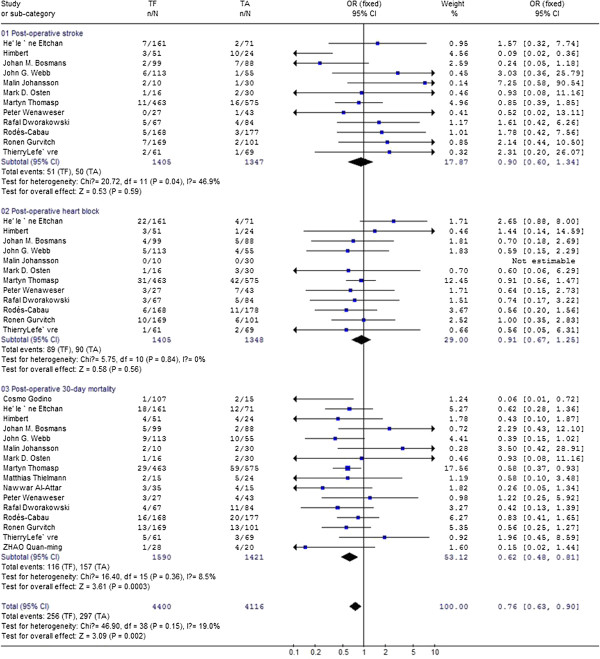
Compare 30-day post-opertive mortality, stroke, heart block between transfemoral aortic valve implantation versus transapical surgery aortic valve replacement for aortic stenosis with studies in which people received only SAPIEN bovine valve was used.